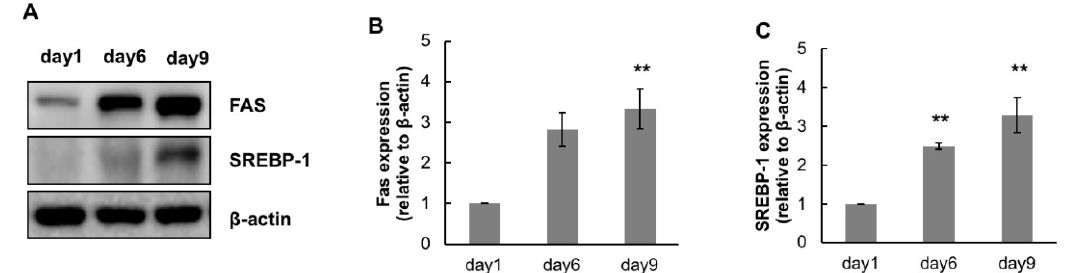
Figure 4. Changes in expression of lipogenic markers over time. The expression of fatty acid synthase (FAS) and SREBP-1, markers for lipogenesis, were measured by Western Blotting at two-time points. To see the lipogenesis in early stage of adipogenic differentiation, hASCs were harvested at 6 days after adipogenic induction. Meanwhile, the lipogenesis in late stage of adipogenic differentiation was investigated at 9 days after adipogenic induction ( A ). Bands were densitometrically analyzed by using ImageJ software (http://rsbweb.nih.gov/ij) ( B , C ). The results are expressed as the mean values ± SD ( n = 3); ** p < 0.05 as compared to the control group (day1); day 1, hASCs were cultured in growth medium only; day 6 and day 9, hASCs were cultured in adipogenic differentiation medium for 6 or 9 days, respectively.